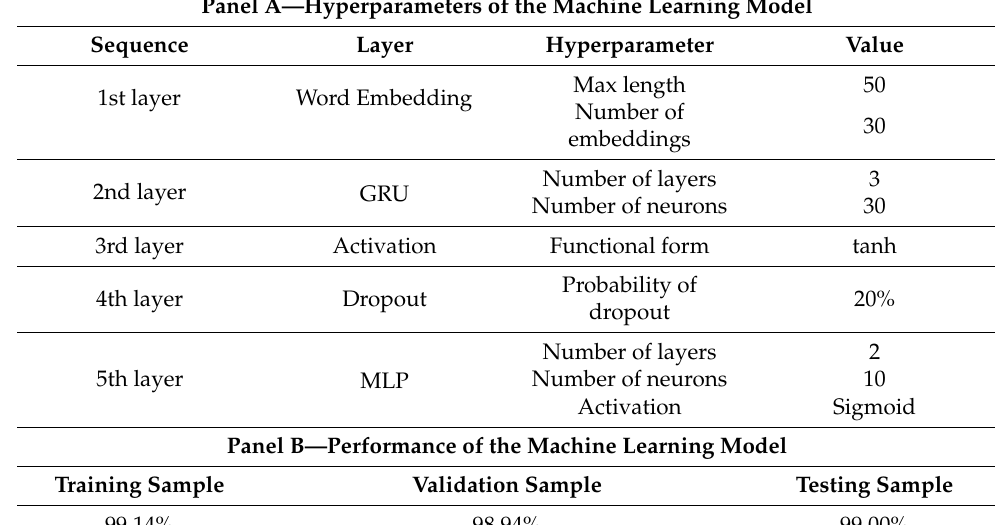
Table 1. Structure, hyperparameters and performance of the model. Panel A—Hyperparameters of the Machine Learning Model Sequence Layer